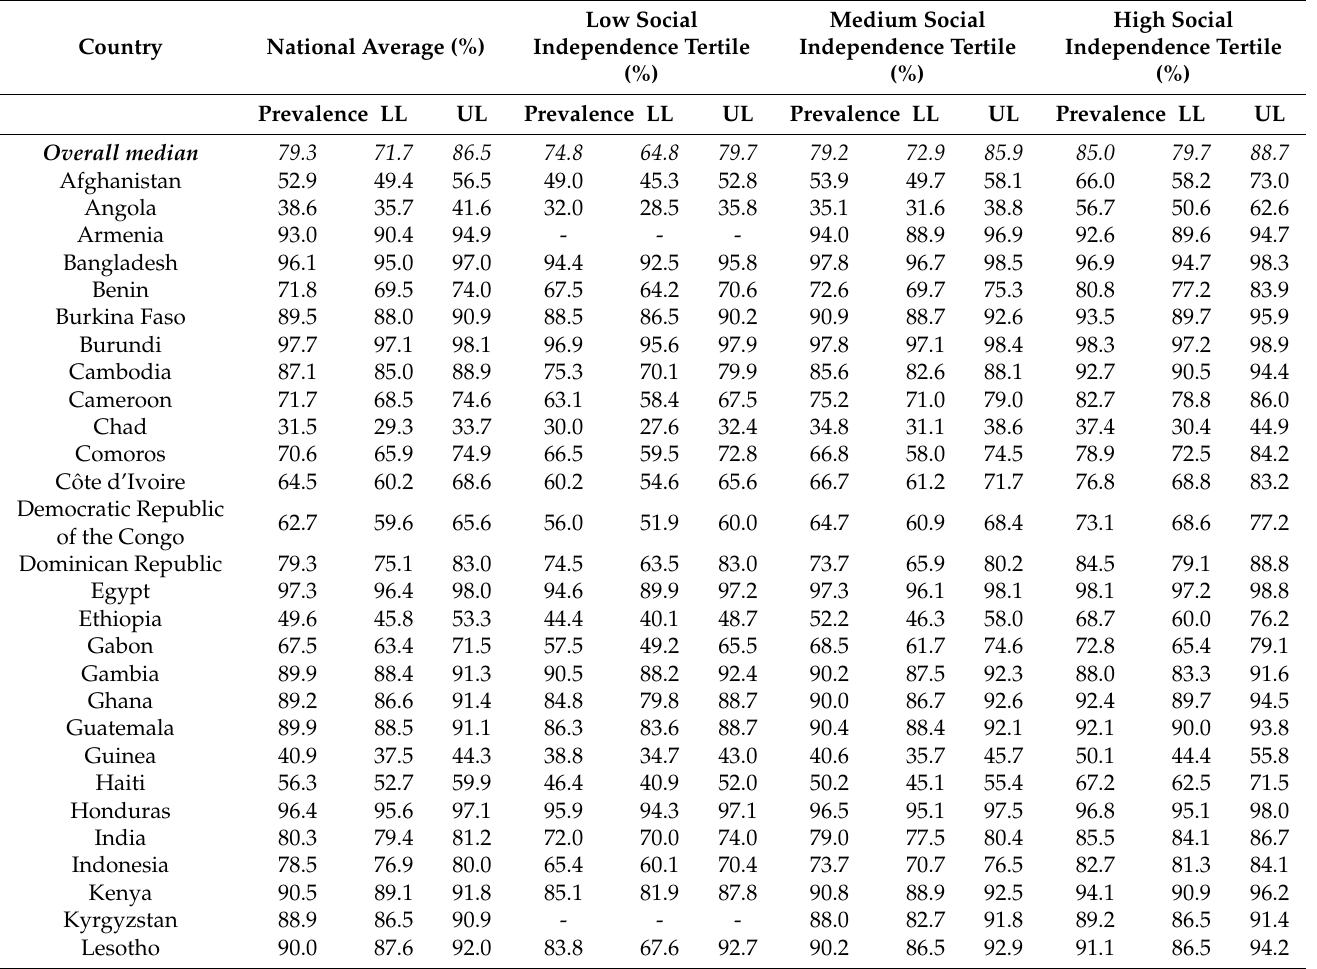
Table 1. DTP3 coverage overall and by SWPER Global Index social independence domain tertile, children age 12–35 months in 52